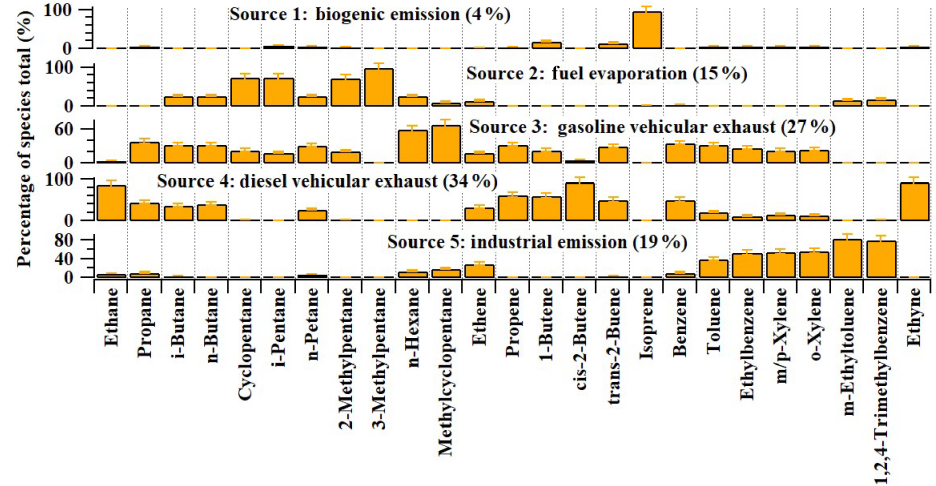
Figure 4. Source profiles of VOCs identified using the PMF model and the relative contributions of the individual VOC species.